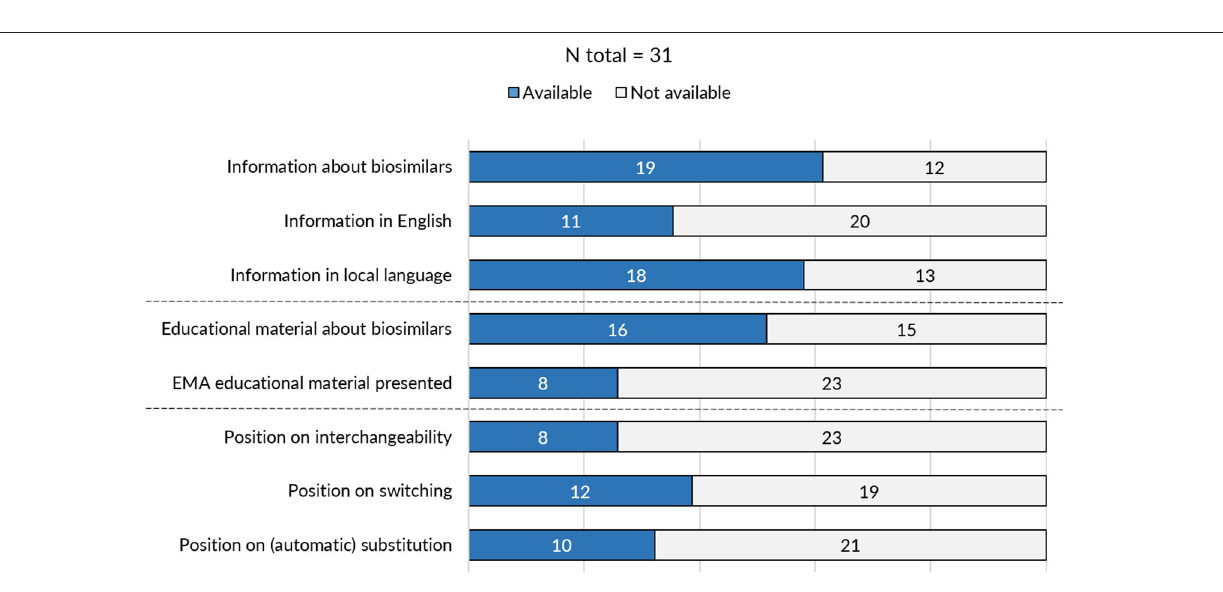
FIGURE 3 | Overview of biosimilar information and guidance provided by national medicines agencies across